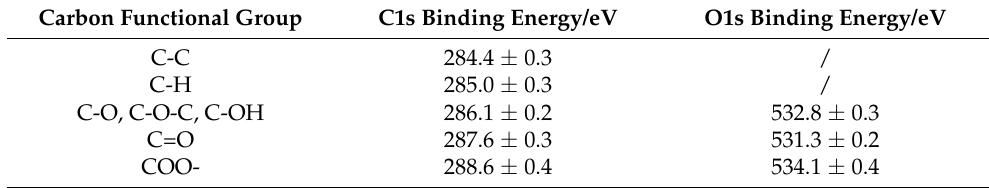
Table 3. Summary of carbon functional groups and corresponding binding energy.